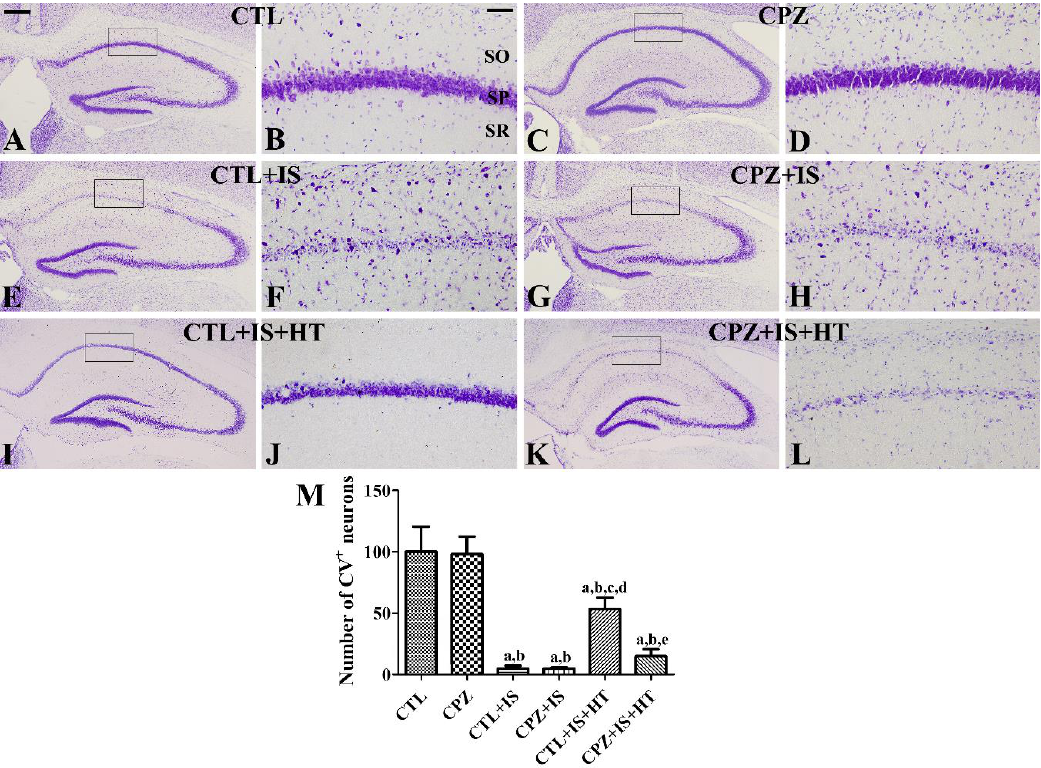
Figure 2. Cresyl violet staining in the hippocampus of the CTL ( A , B ), CPZ ( C , D ), CTL + IS ( E , F ), CPZ + IS ( G , H ), CTL + IS + HT ( I , J ), and CPZ + IS + HT ( K , L ) groups. Cresyl violet-stained neurons were abundantly observed in the hippocampus of the CTL and CPZ groups, while few cresyl violet-stained neurons were detected in the stratum pyramidale (SP) of the CA1 region in the CTL + IS, CPZ + IS, and CPZ + IS + HT groups. Note that there are numerous cresyl violet-stained neurons in the CTL + IS + HT group. SO, stratum oriens; SR, stratum radiatum. Scale bar = 400 μM ( A , C , E , G , I , K ), 50 μM ( B , D , F , H , J , L ). ( M ) The number of cresyl violet-stained neurons compared to the CTL group per section, in all the groups, is shown ( n = 5 per group, a p < 0.05, significantly different from the CTL group; b p < 0.05, significantly different from the CPZ group; c p < 0.05, significantly different from the CTL + IS group; d p < 0.05, significantly di ff erent from the CPZ + IS group; e p < 0.05,